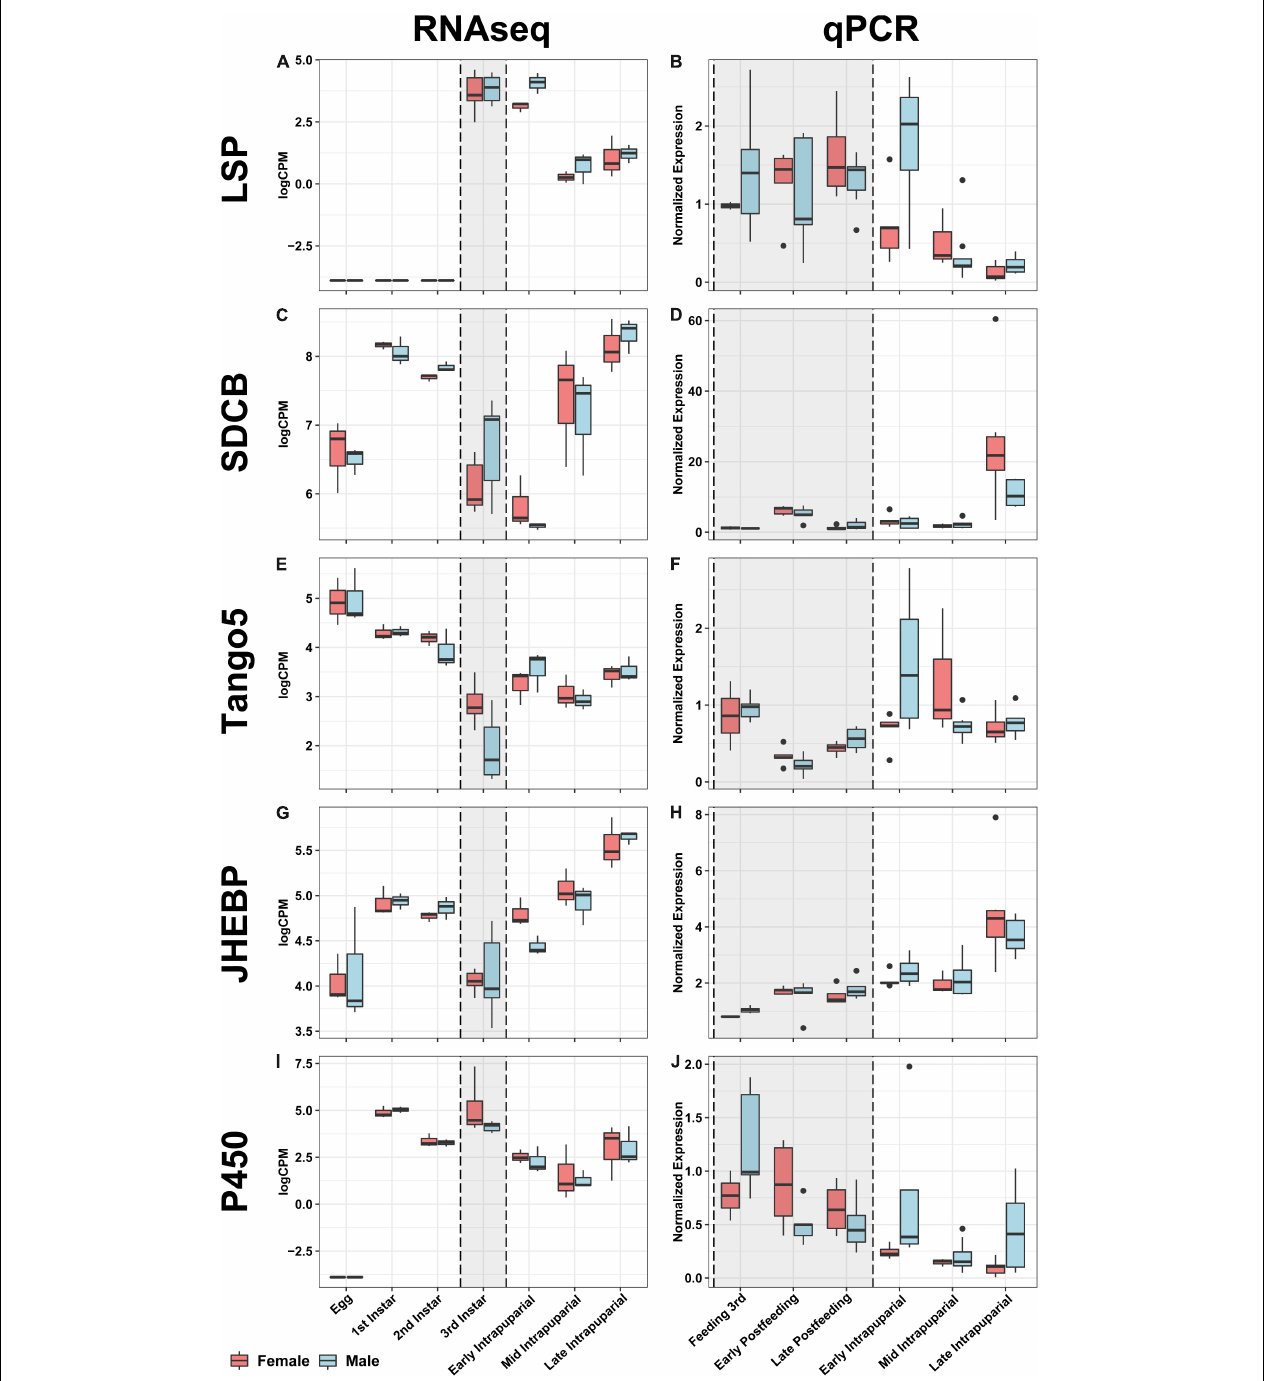
FIGURE 10 | Comparative boxplots of genes selected for validation. RNAseq expression in the left column and qPCR normalized expression in the right column for each node for which primers were designed in the rows (see Table 4 ). Each boxplot for the RNAseq column represents three separate individuals, with the exception of the third instar samples (gray background shaded box), which represents six individuals collected to evaluate gene expression correlated with facultative predatory behavior, and therefore are likely to be feeding third instars. Eleven samples were evaluated for each time point with qPCR validation, and sampling also broke up the third instar into three separate time points, all indicated in the gray shaded box; see Table 3 and materials and methods section “Validation Fly Rearing” for more details. From left to right, top to bottom: (A) RNAseq expression of Larval serum protein 1a (Lsp1a) , (B) qPCR expression of Lsp1a , (C) RNAseq expression of Succinate dehydrogenase cytochrome B (SDCB) , (D) qPCR expression of SDCB , (E) RNAseq expression of Transport and Golgi organization 5 (Tango5) , (F) qPCR expression of Tango5 , (G) RNAseq expression of Juvenile hormone esterase binding protein (JHEBP) , (H) qPCR expression of JHEBP , (I) RNAseq expression of a cytochrome p450 (P450), (J) qPCR expression of P450.